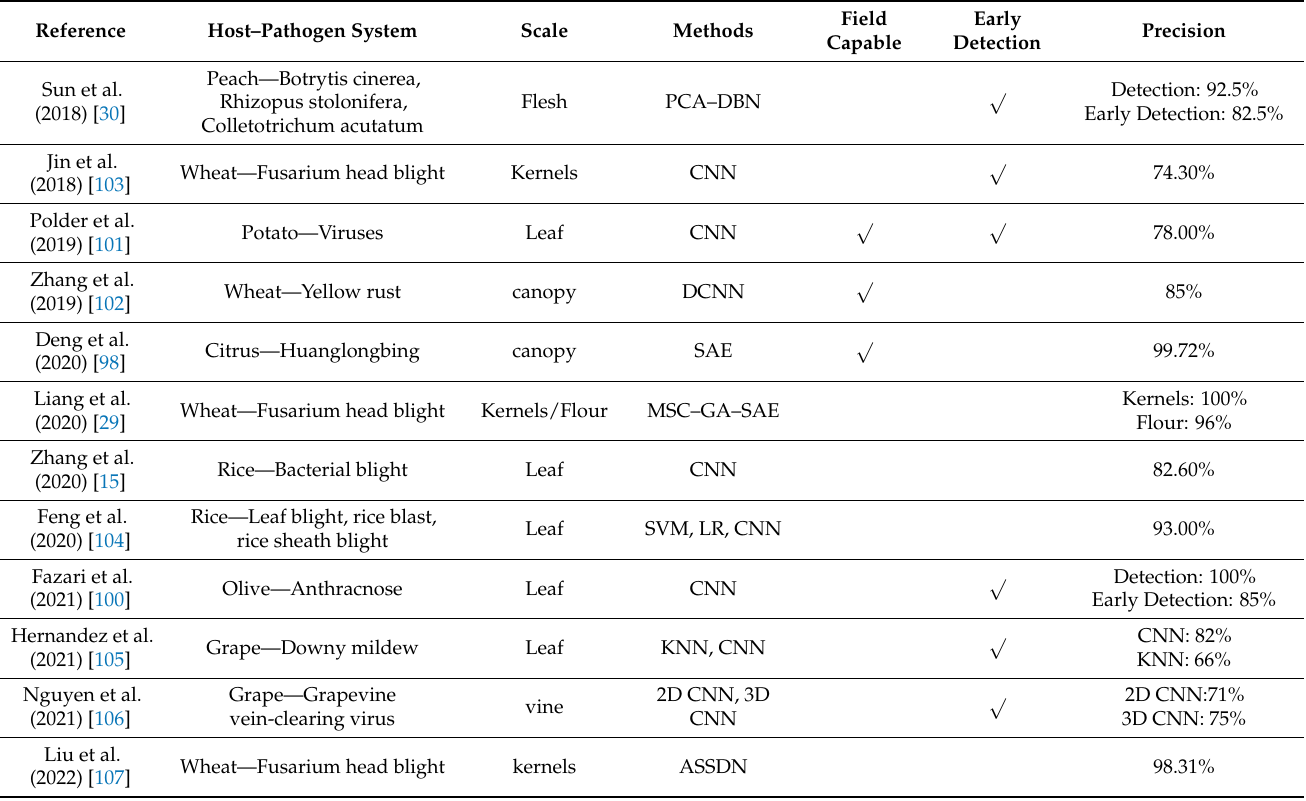
Table 5. Recent advances in plant disease detection based on deep